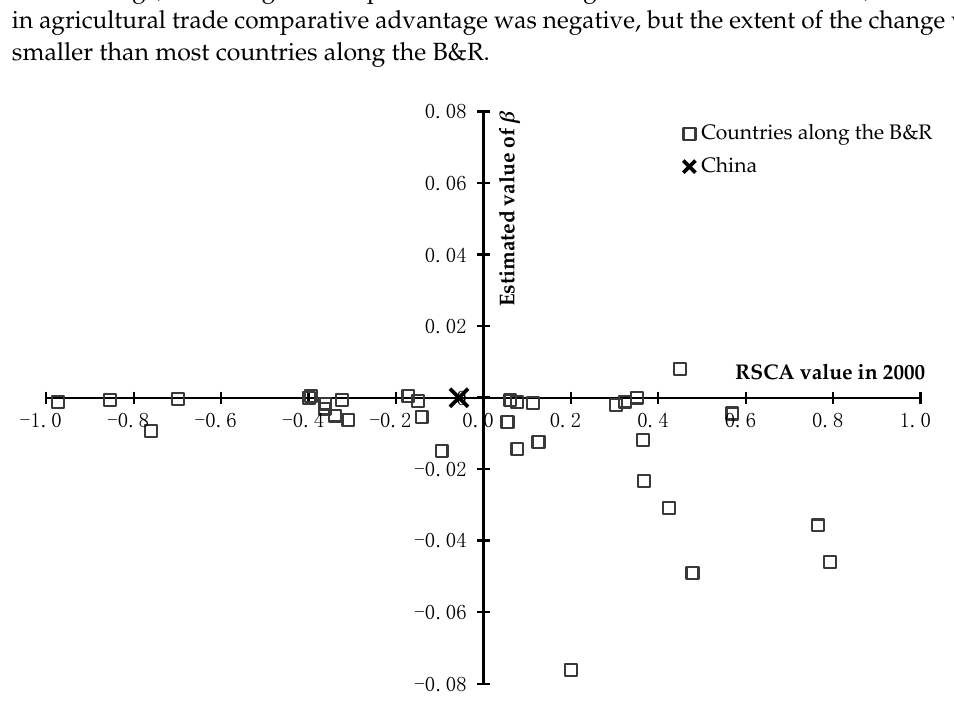
β β > > 0 is supposed to reveal an increase in comparative A A . β A . 0 i , t i , t , i t , i t < 0 is supposed to reveal a decrease in comparative advantage i , t